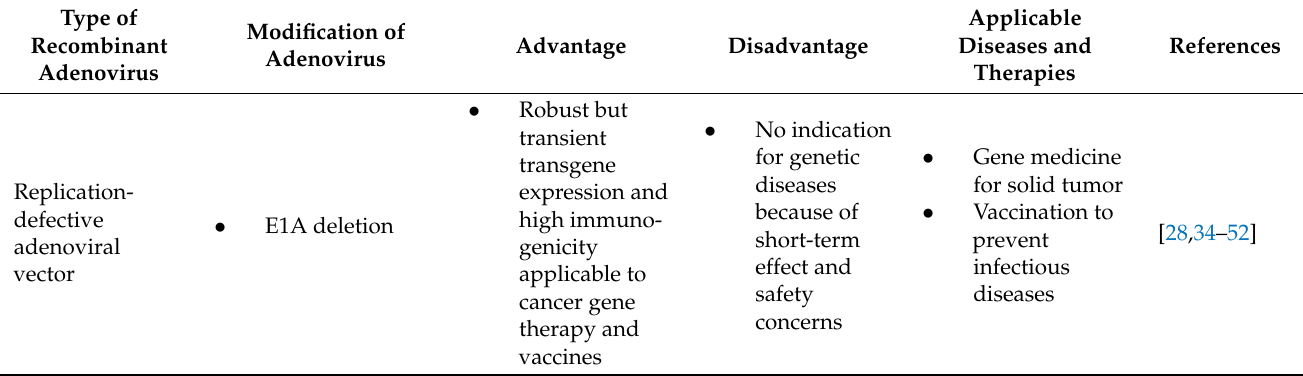
Table 1. The characteristic features of recombinant